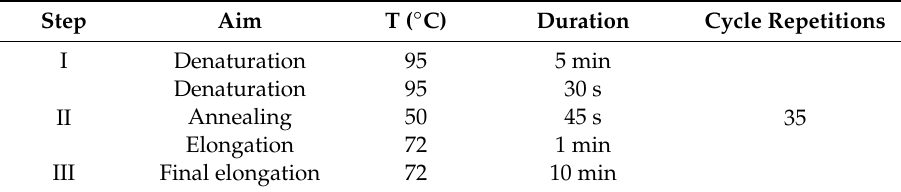
Table 1. Thermocycling protocol for